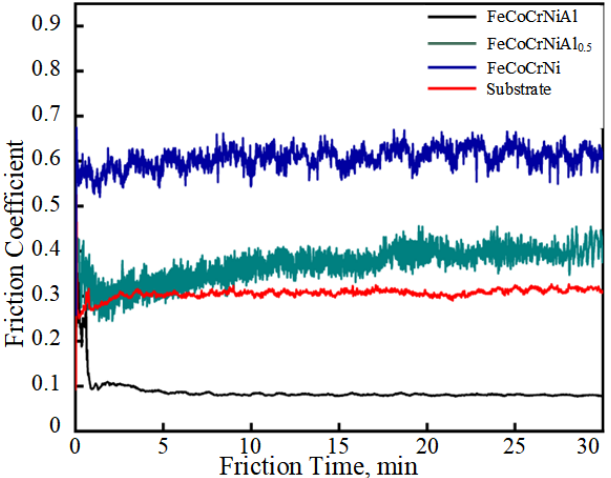
Figure 7. Coefficients of friction of the coatings with different Al contents.